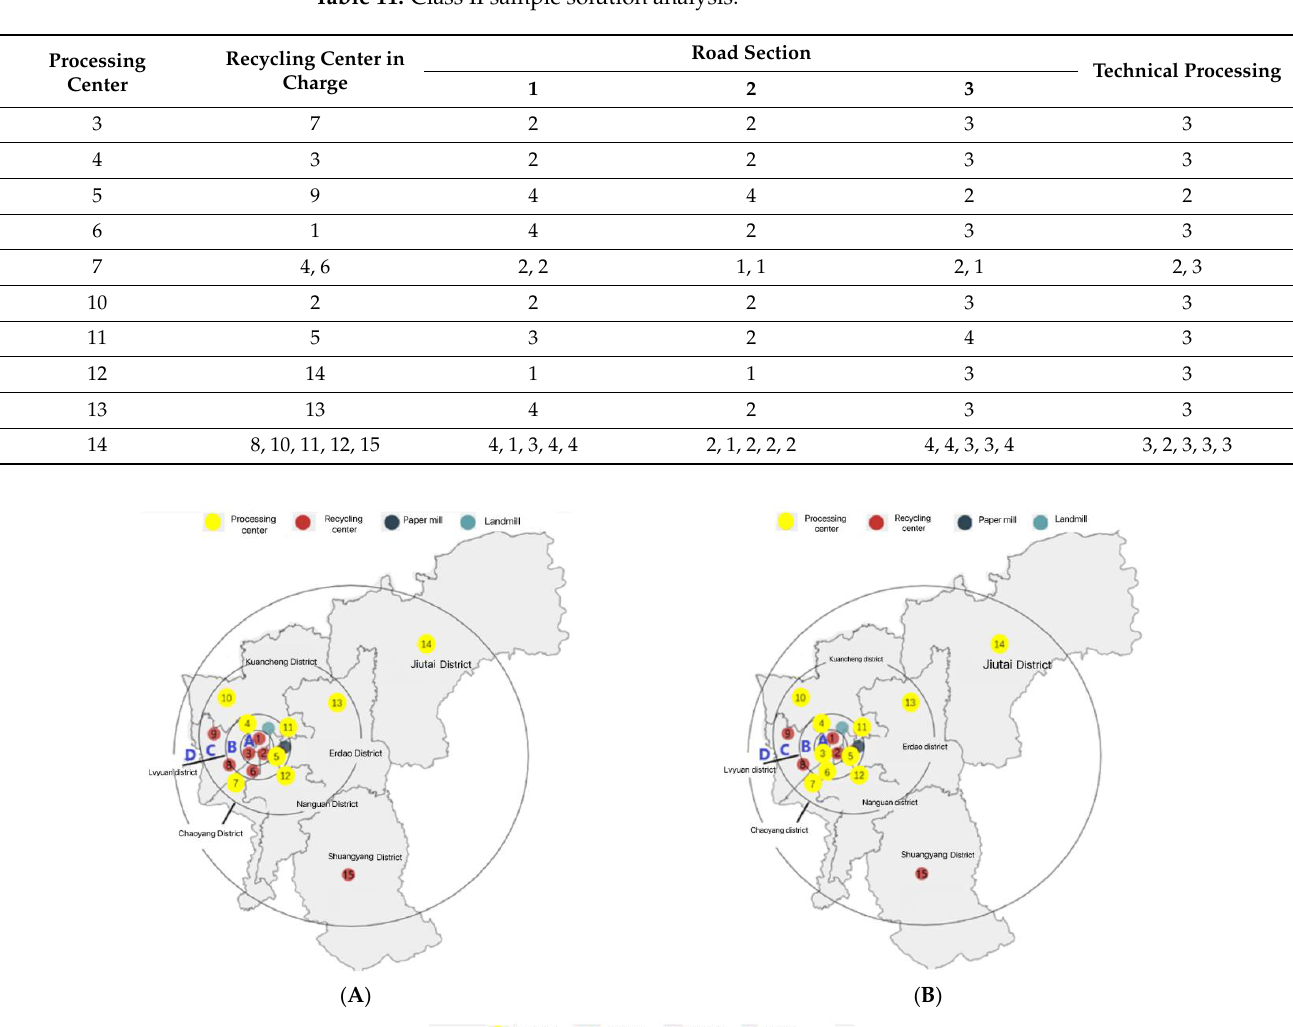
Table 11. Class II sample solution analysis.